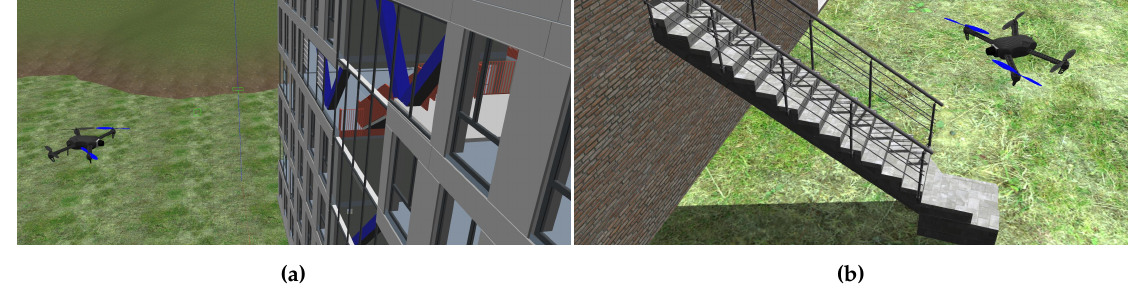
Figure 1. The simulated unmanned aerial vehicle (UAV) autonomously navigates around virtual Building Information Modelling (BIM)-derived building scenes. ( a ) Example of a building model with few surface details. ( b ) Example of a building with realistic textures. The additional surface features greatly improve depth sensing in